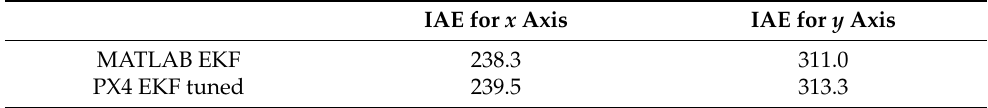
Table 2. Quality Table 2. Quality indicator.